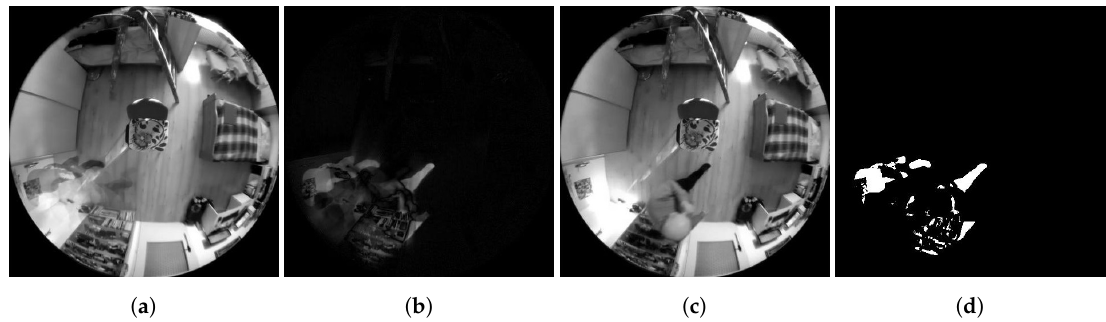
Figure 15. Diagram of Method 2.3 activity—creation of a new background.